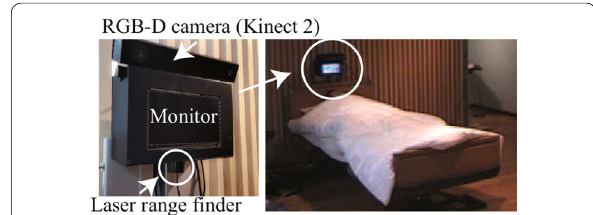
Fig. 6 Sensor terminal for monitoring vital data